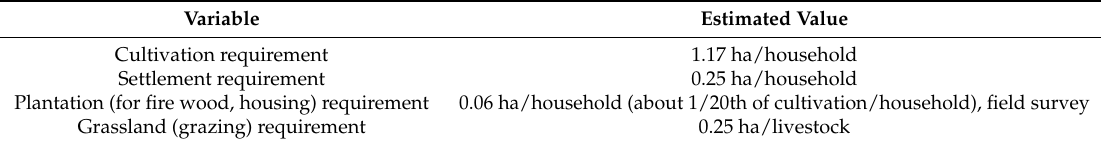
Table 2. General demand estimations based on Mengistu [41] and Jayne et al. [42]